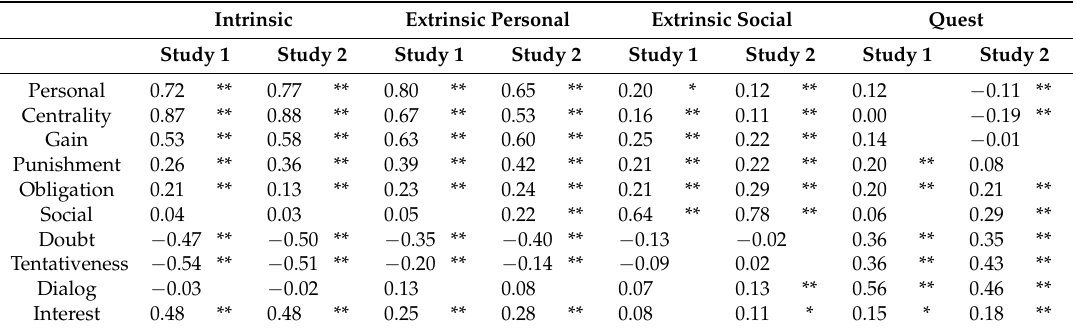
Table 4. Correlations from both samples between the CROI subscales and established measures of I/E-Revised and Quest. Intrinsic Extrinsic Personal Extrinsic Social Quest Study 1 Study 2 Study 1 Study